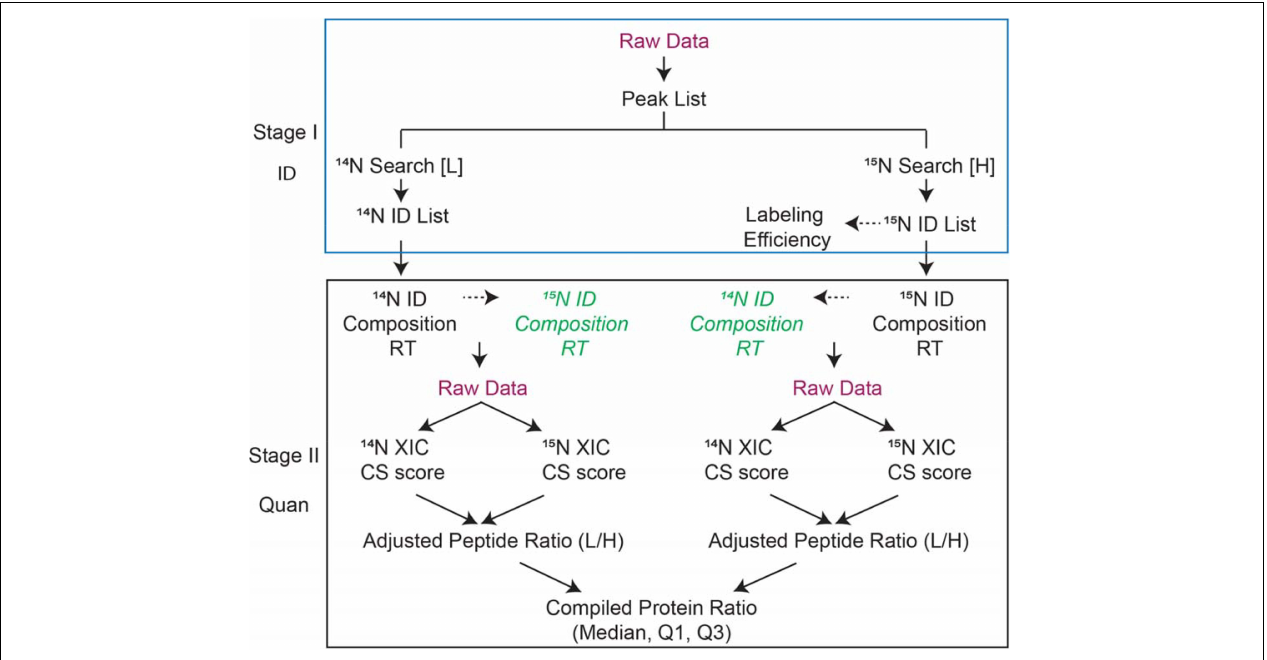
FIGURE 1 | Workflow of 15 N metabolic labeling protein quantification used in Protein Prospector. There are two stages: Stage I-Identification of proteins; Stage II-Quantification of proteins/peptides. Labeling efficiency is determined by the user and then input as a parameter to correct ratios to generate adjusted peptide ratios. Based on the identification of peptides either from 14 N search [L] or 15 N search [H], the PP software finds the matching counterpart and retrieves isotope cluster intensities and/or areas. The ratios between the peptide pair are reported and compiled into protein-level statistics such as median and interquartile ranges. CS scores are calculated on the matched pairs based on the comparison of experimental vs. theoretical isotope